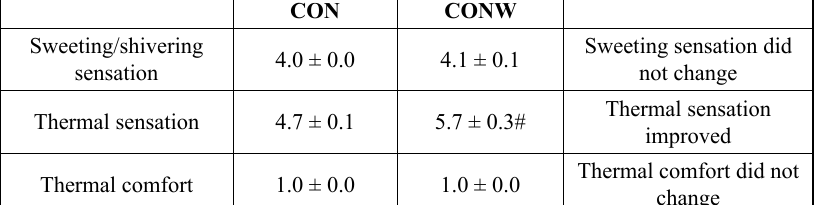
Table 2. Sweating/shivering